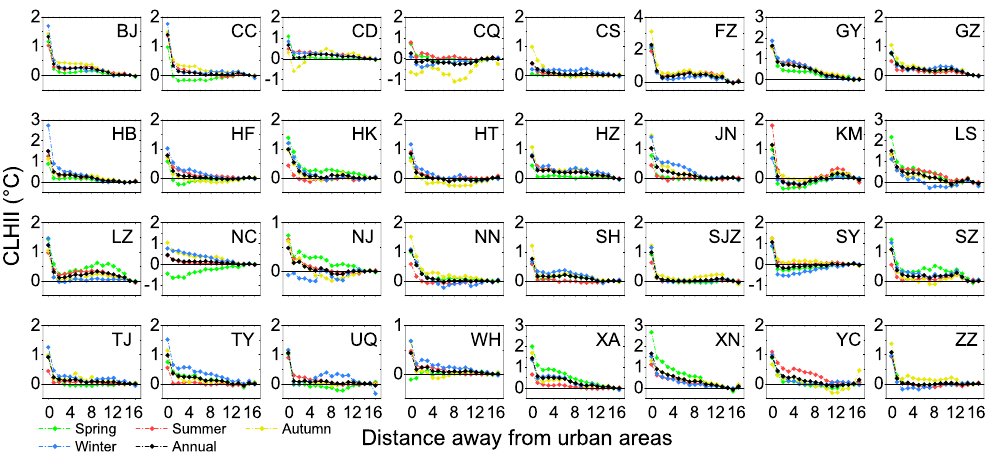
Figure 6. Surface air temperature difference between urban buffers and background areas in China’s 32 major cities: 0 represents urban areas, 1 represents suburban areas of the same area as the urban areas, and 2 – 16 represent the buffers radiating outwards from urban to rural areas at 1-km intervals. Remote Sens. 2019 , 11 , x FOR PEER REVIEW